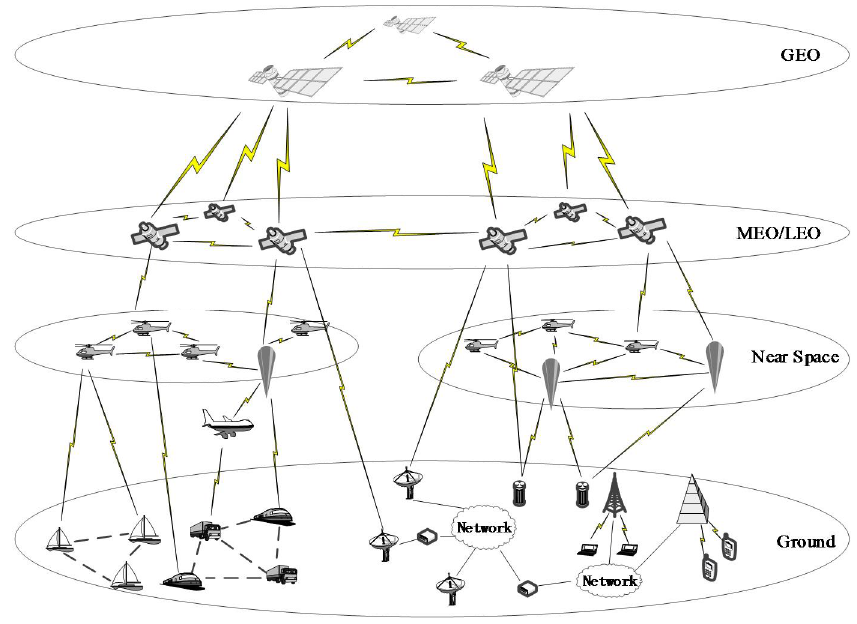
Figure 1. C omposition and architecture of SIN . Figure 1. Composition and architecture of